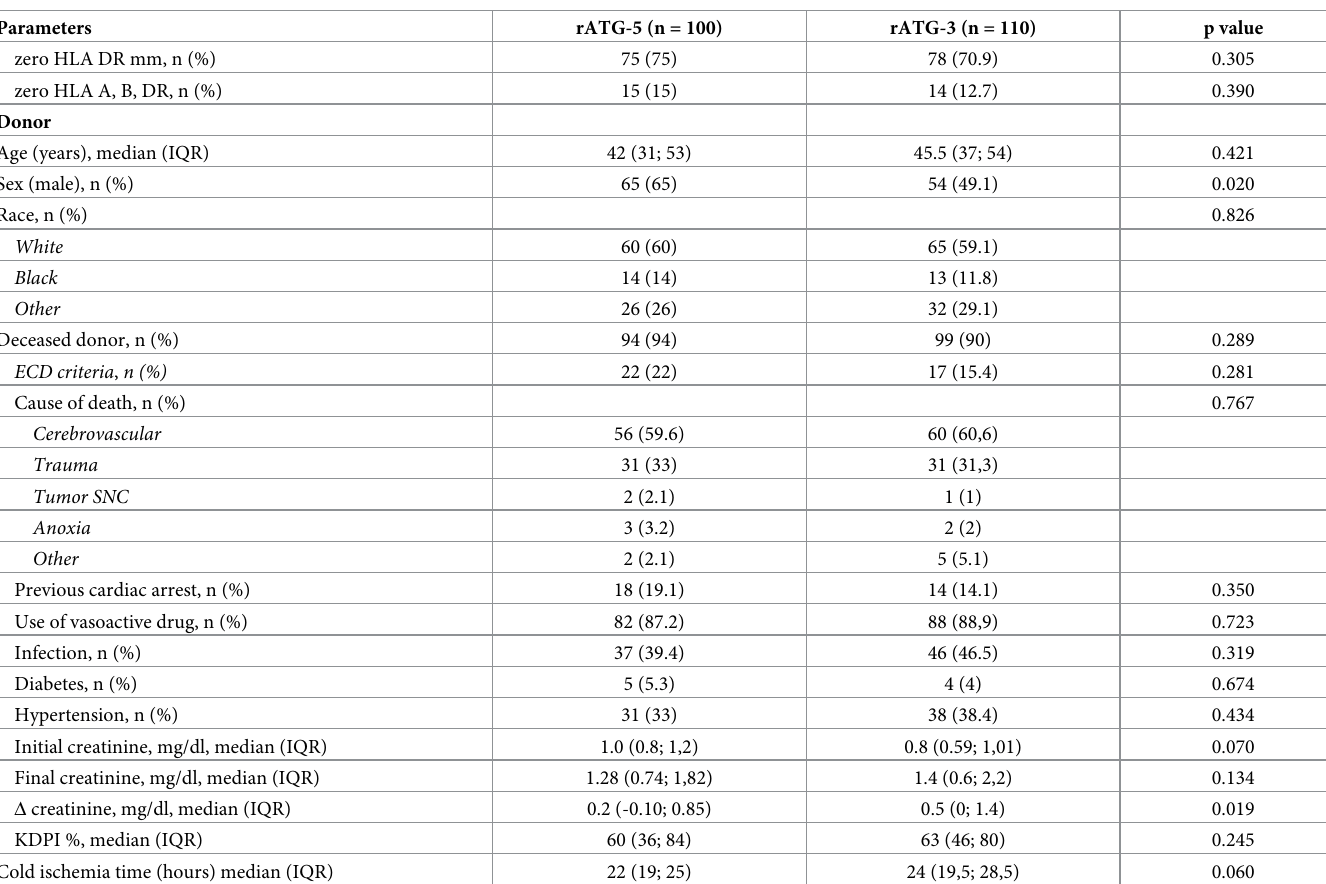
episodes of acute rejection. Overall, there was no difference in the total number of treated acute rejection episodes (rATG-5, n = 30 vs. rATG-3, n = 28), yet the total number of antibody mediated and mixed acute rejection episodes in the rATG-3 was higher compared to rATG-5 group (11 vs. 4, Table 3), respectively. There was also no difference in the incidence or specific causes of graft loss and death. Because 36 patients in the rATG group did not receive the intended total dose due to adverse events, a subgroup analysis revealed a higher incidence of first treated acute rejection (30.6% vs. 18.8%, p = 0.178) and first BCAR � IA (19.4 vs. 4.7%, p = 0.033) comparing patients The number of treated acute rejection episodes and graft losses from month 12 to month 36 were comparable but a higher number of deaths were observed in the rATG-5 compared